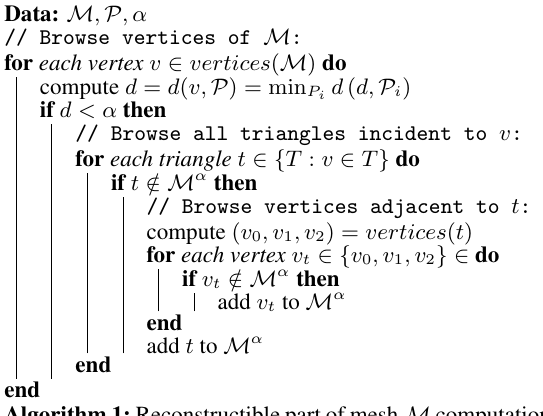
Algorithm 1: Reconstructible part of mesh M